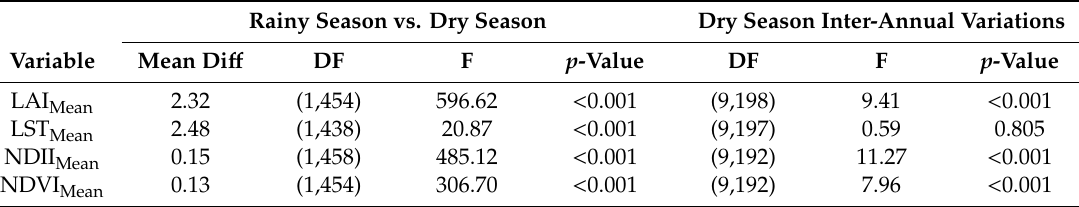
Table 2. Repeated measure-analysis of variance(RM-ANOVA) test results for variables. Rainy Season vs. Dry Season Dry Season Inter-Annual Variations Variable Mean Di ff DF F p -Value DF F p